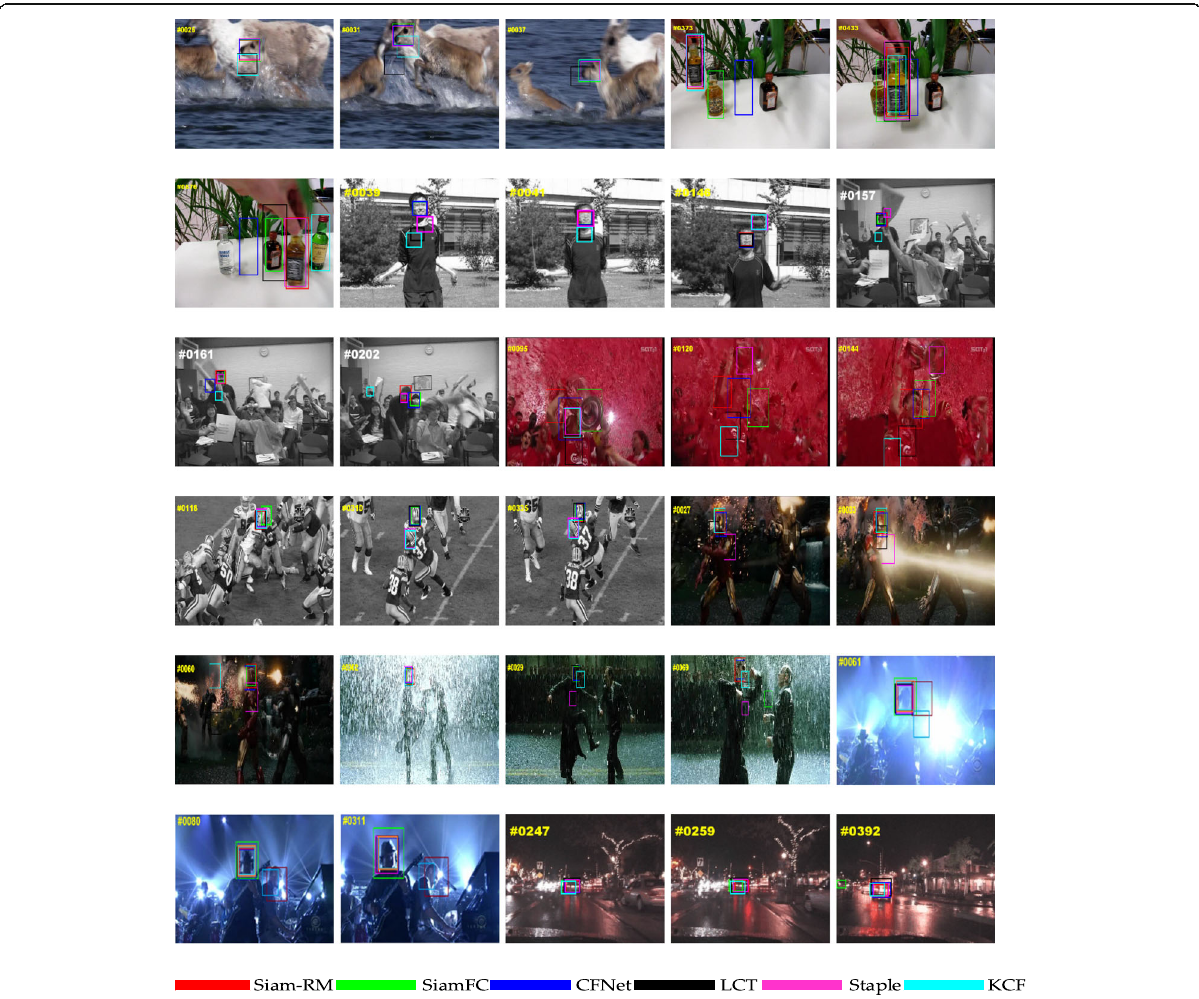
Fig. 8 Tracking results of the sequences. For a further clear comparison, some challenging video sequences are selected from all OTB sequences. These video sequences represent different complex scenes. In order to show the results more clearly, six tracking algorithms are selected for comparison in this part. In each image, the boxes with different colors represent the corresponding tracking positions of different trackers. The legend shows the relationship between the different colors and the corresponding